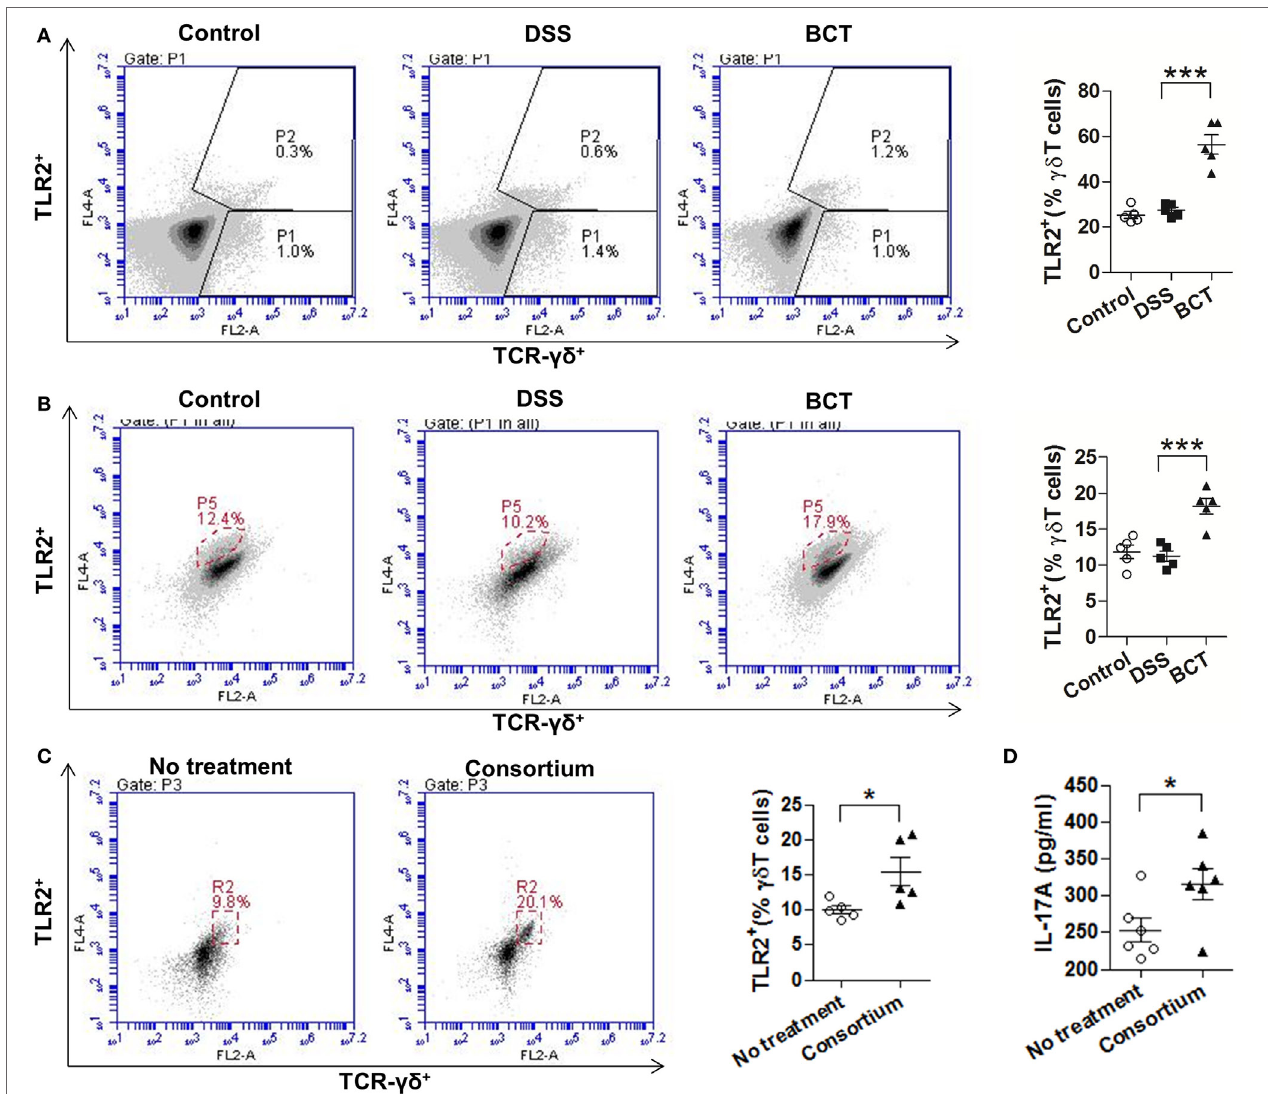
FigUre 4 | The bacterial consortium promoted the expansion of TLR2 + γδ T cells. (a) TLR2 + γδ T cells in colonic lamina propria (cLP) of colitis mice were upregulated post-transplantation of the bacterial consortium. Left panel, representative flow cytometry analysis of TLR2 + γδ T (TLR2 + TCR- γδ + ) cells in cLP of mice from different groups at day 7. Right panel, the proportion of TLR2 + γδ T cells in total cLP γδ T cells. (B) TLR2 + γδ T cells in spleen of colitis mice were upregulated post-transplantation of the bacterial consortium. Left panel, representative flow cytometry analysis of MACS-purified splenic γδ T cells from mice of different groups at day 7; right panel, the proportion of TLR2 + γδ T cells in total splenic γδ T cells. (c) Effects of the bacterial consortium on TLR2 expression of purified splenic γδ T cells. Representative flow cytometry plots and evaluation of the percentage of TLR2 + γδ T cells among γδ T cells treated or un-treated with 30 µl of the bacterial consortium in vitro . The γδ T cells were purified by MACS from the spleen of C57BL/6J mice at day 7, which belonged to the control group. (D) IL-17A concentration in the supernatant of purified γδ T cells treated or un-treated with 30 µl of the bacterial consortium in vitro detected by ELISA. All values are mean ± SEM ( n = 5). Statistical analysis of the quantitative multiple group comparisons was performed using one-way analysis of variance followed by Tukey’s test; when two groups were compared, the non-parametric t -test was performed by the assistant of GraphPad Prism 5. * p < 0.05, ** p < 0.01,*** p <